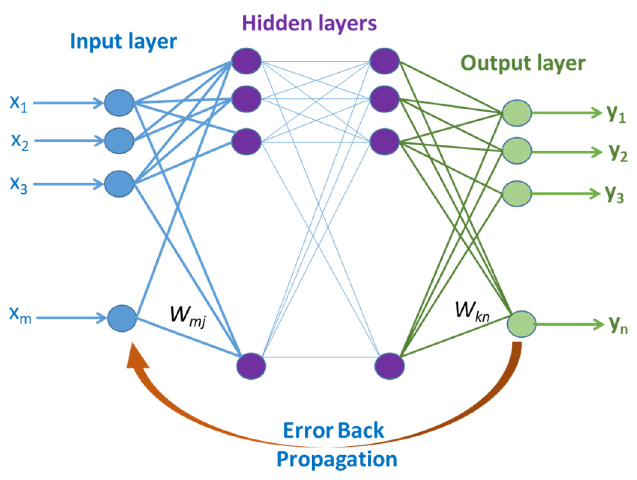
Figure 5. The generic architecture of ANN .